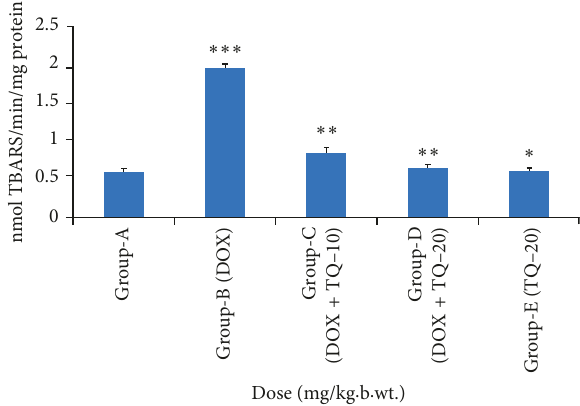
Figure 2: Effect of thymoquinone on LPO levels in cardiac tissue in mice.